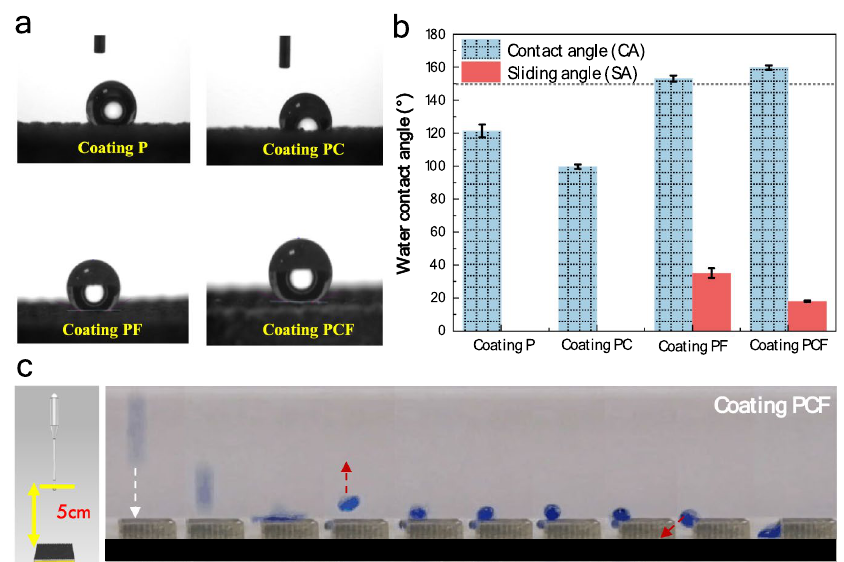
Figure 3. Surface wettability of as-modified amorphous coatings. ( a ) The contact of water droplet on the 4 different coatings, including as-patterning coating (coating P), the coating modified only with Cu 2 O (coating PC), the coating modified only with FAS (coating PF), and the coating with dual modifications (coating PCF). ( b ) Water contact angle (CA) and sliding angle (SA) of the coatings. ( c ) The images illustrate water droplets bouncing on the coating PCF.